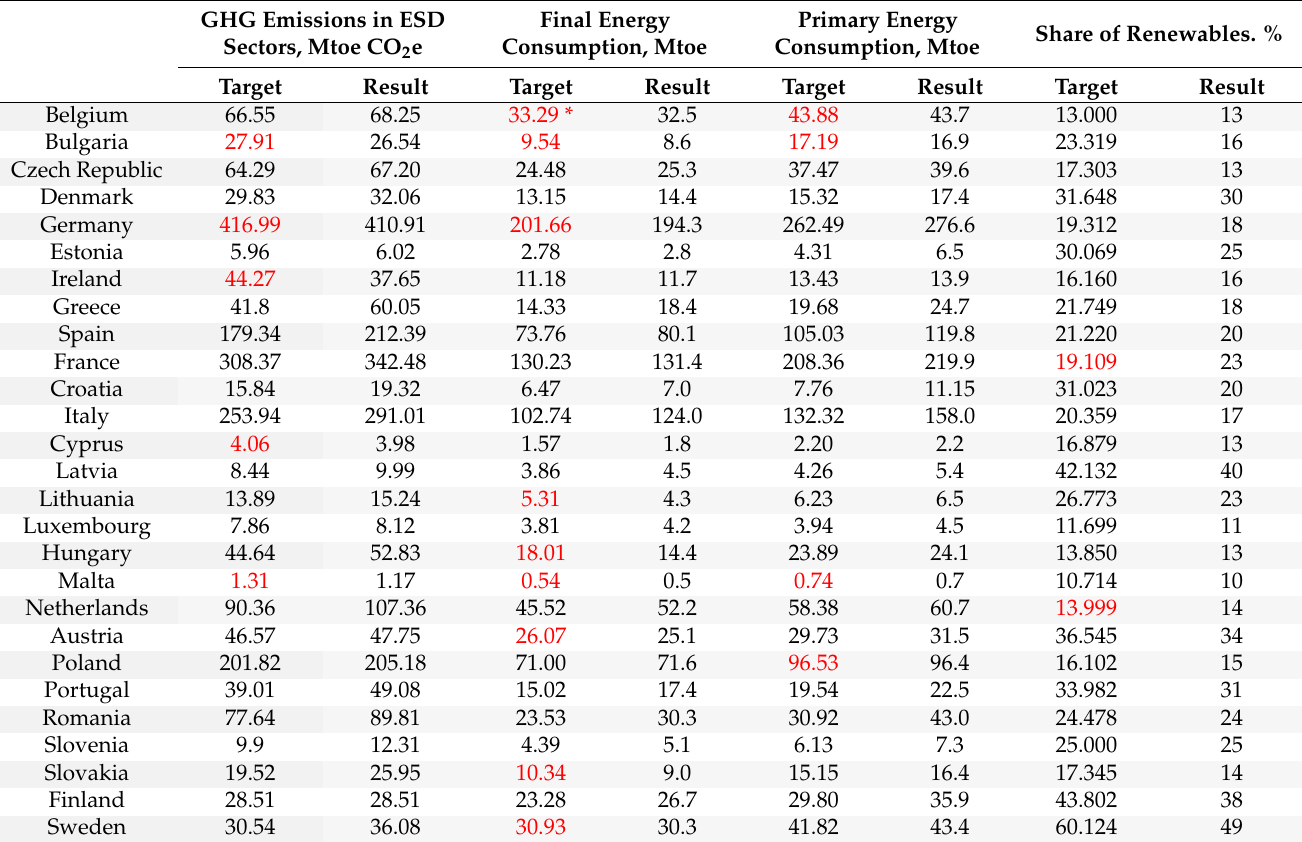
Table 3. Climate change and energy policy national targets of the Europe 2020 Strategy and its implementation among countries in 2020. Source: